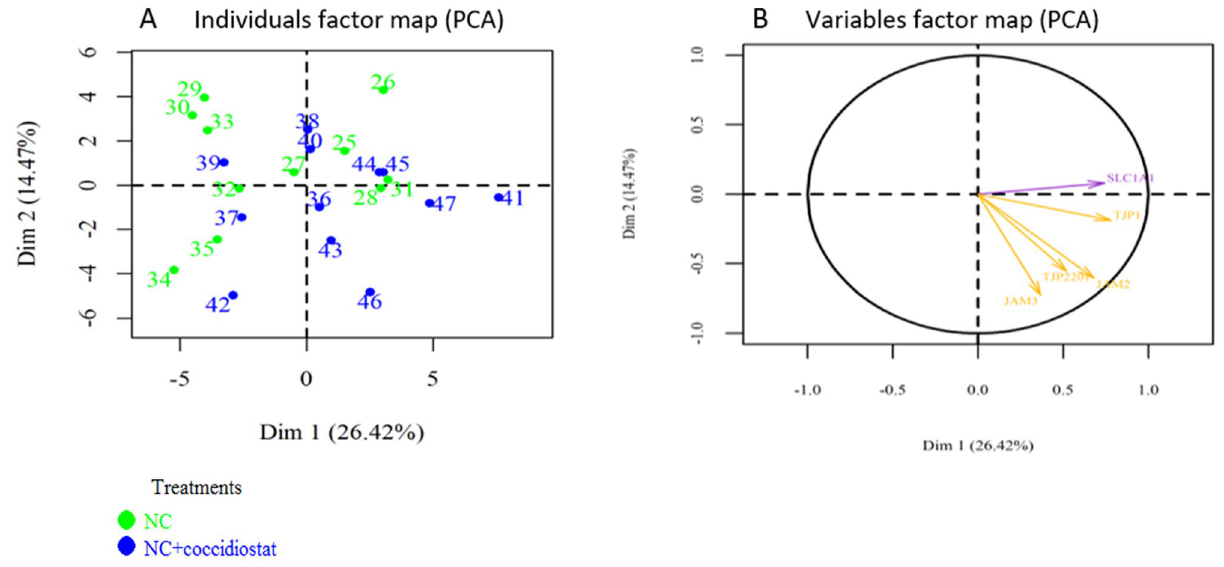
Figure 5. PCA representations of intestinal gene expression data in ileum chicken broiler samples ( A ) The samples dot plot; ( B ) variables arrow